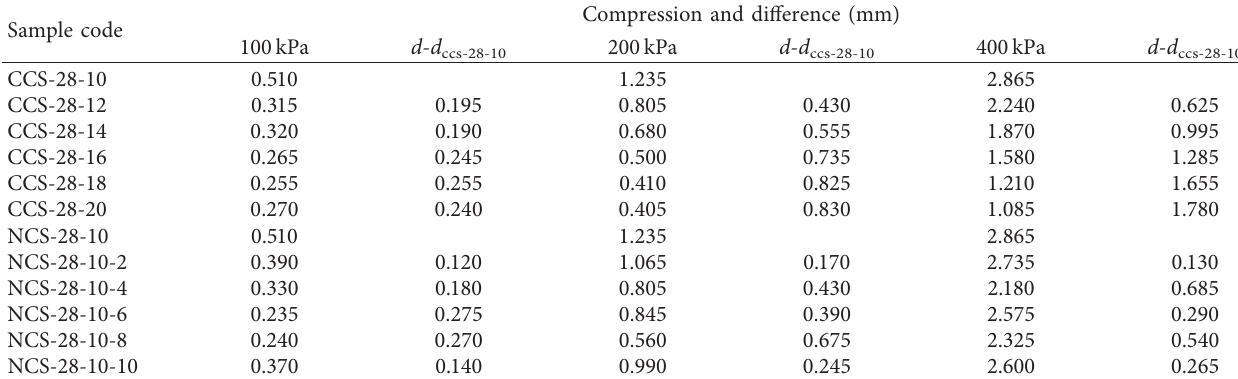
Table 8: Comparison of compression between NCS and